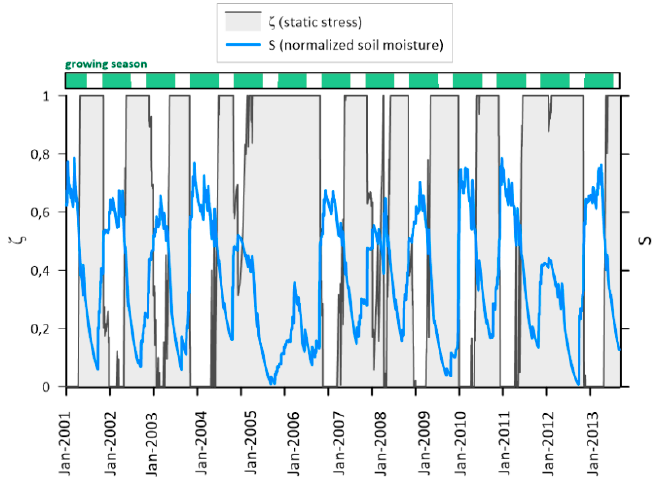
Figure 4. Evolution of normalized soil moisture (blue) and static stress (gray) over the study period. Growing season extent is indicated in